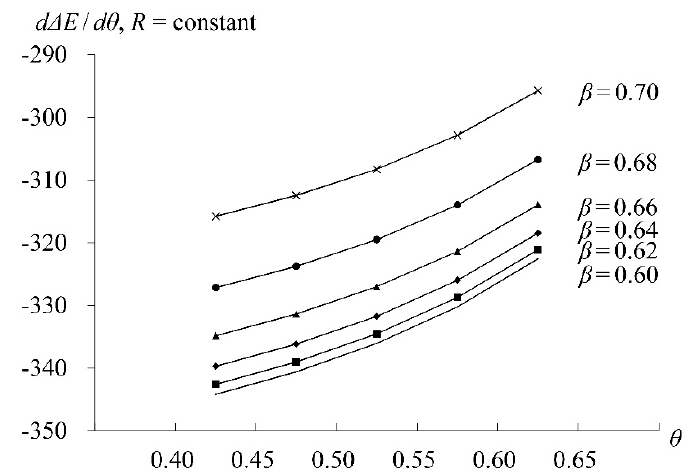
Figure 5. Responsiveness of efficiency gain to buying distressed assets at various levels of shadow-banking transaction based on Equation (20). All results are valued at the optimal R A of 5.60%. The negative indirect effect, ( ∂ ∆ E / ∂ R A )( ∂ R A / ∂θ ) < 0, consistently reinforces the negative direct effect, ∂ ∆ E / ∂θ < 0 at various levels of shadow-banking transaction.